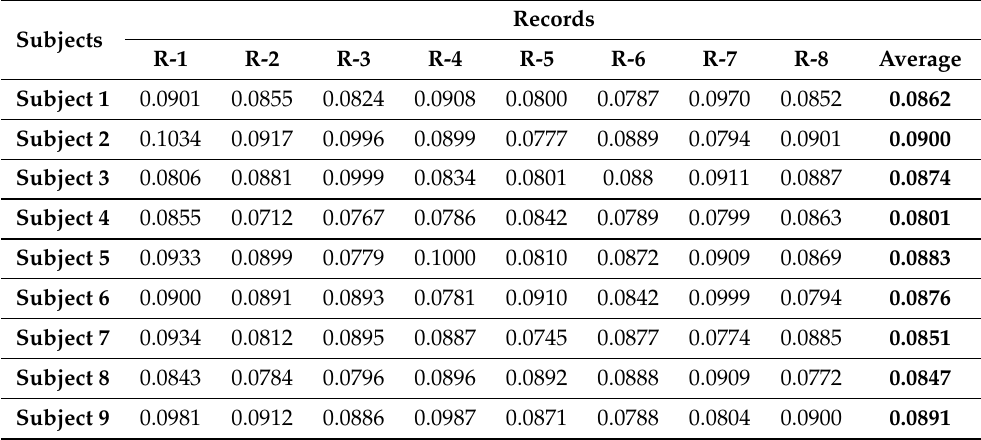
Figure 7. Clean EEG signal of extracted EOG artifact from raw EEG signal using proposed method. Table 2. MAE values of real EEG